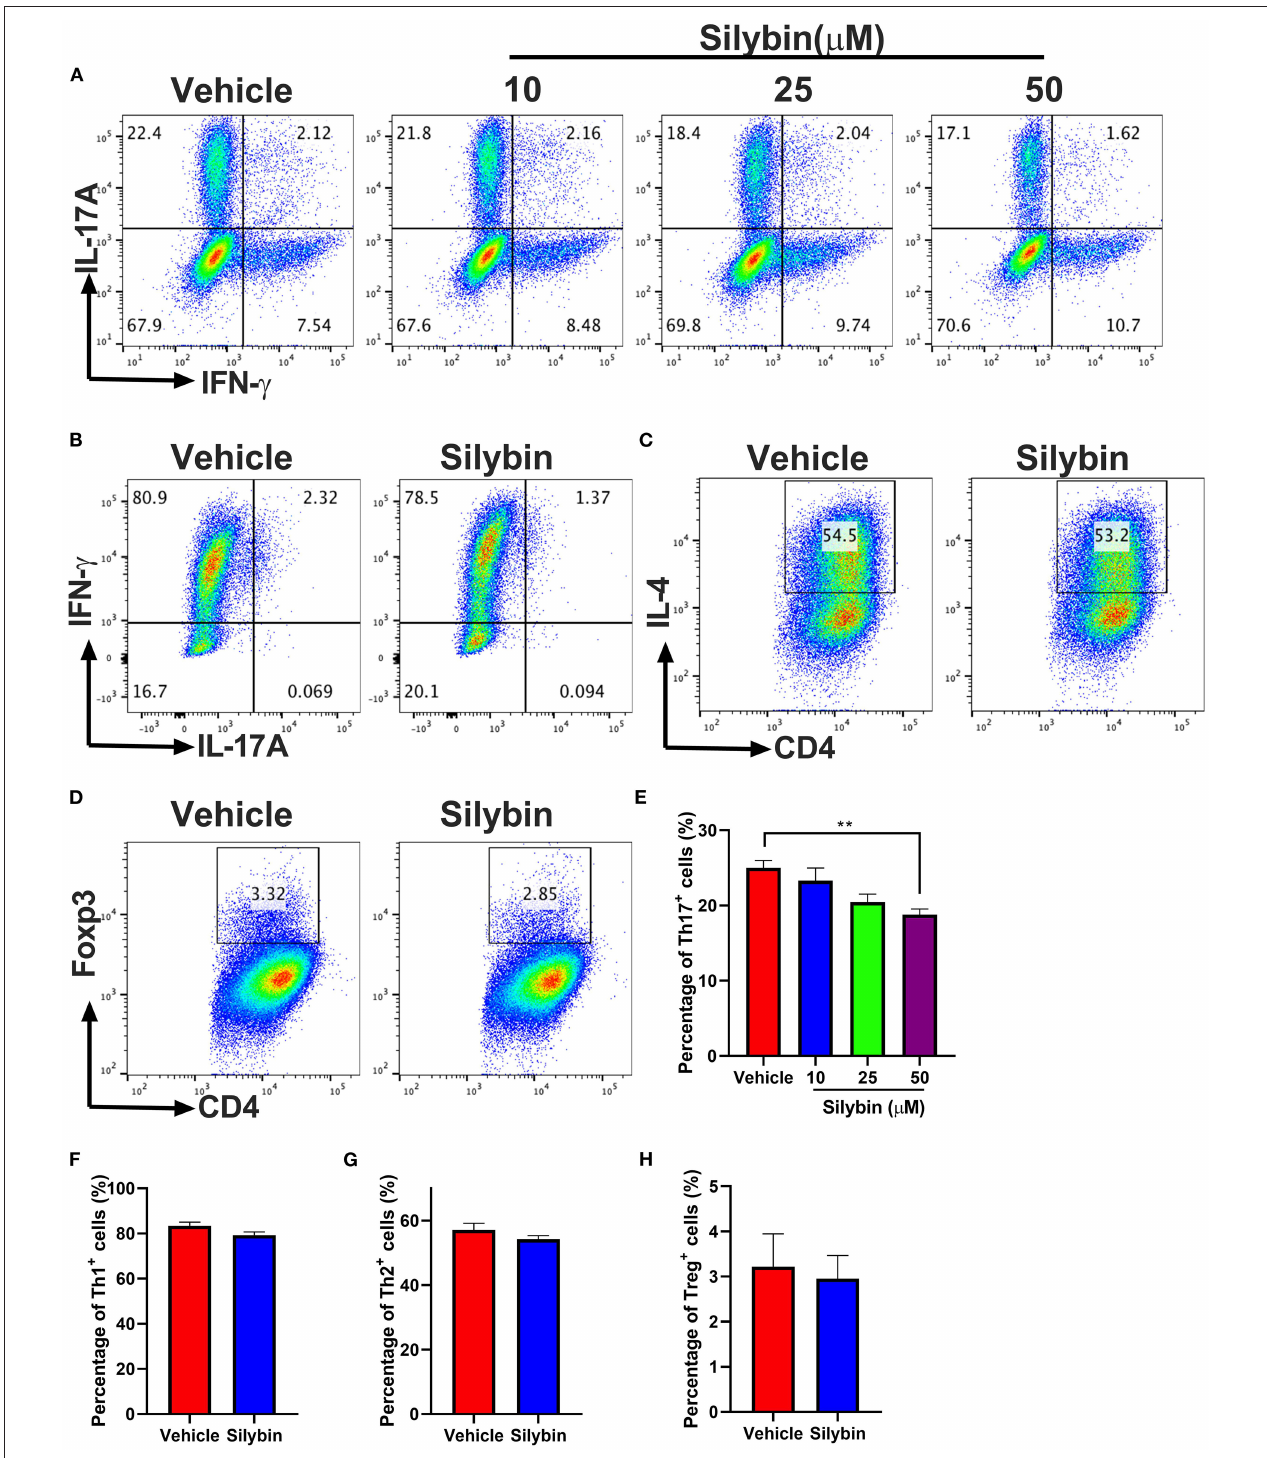
FIGURE 6 | Silybin inhibited Th cell subset differentiation. (A) CD4 + cells were isolated from mice and cultured under the Th17-polarizing condition with different concentrations of silybin for 3 days. Percentage of IL-17A + cells was analyzed by intracellular staining of IL-17A. (B–D) CD4 + cells were cultured under the Th1, Th2, and Treg-polarizing conditions with silybin (50 µ M) for 3 days. Percentages of Th1, Th2, and Treg cells were analyzed by intracellular staining of IFN- γ + , IL-4 + , and Foxp3 + , respectively. The RNA extracted from the vehicle- or silybin-treated DCs and RT-PCR was performed to determine the mRNA expression level of IL-1 β , IL-6, IL-23, and TGF- β . (E–H) Statistical analysis of (A–D) . Data represent mean ± SD ( n = 3 each group). ** p < 0.01. Student’s t -test. One representative of three independent experiments is shown.